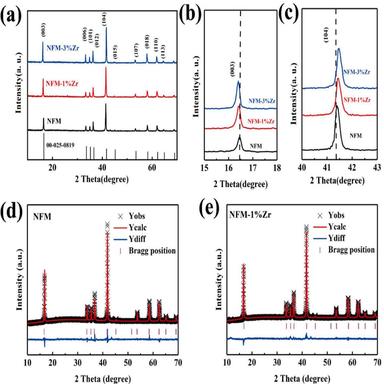
(a) XRD spectra of all specimens, (b) (003) peak, (c) (104) peak, the refined spectra of (d) NFM and (e) NFM-1 %Zr.